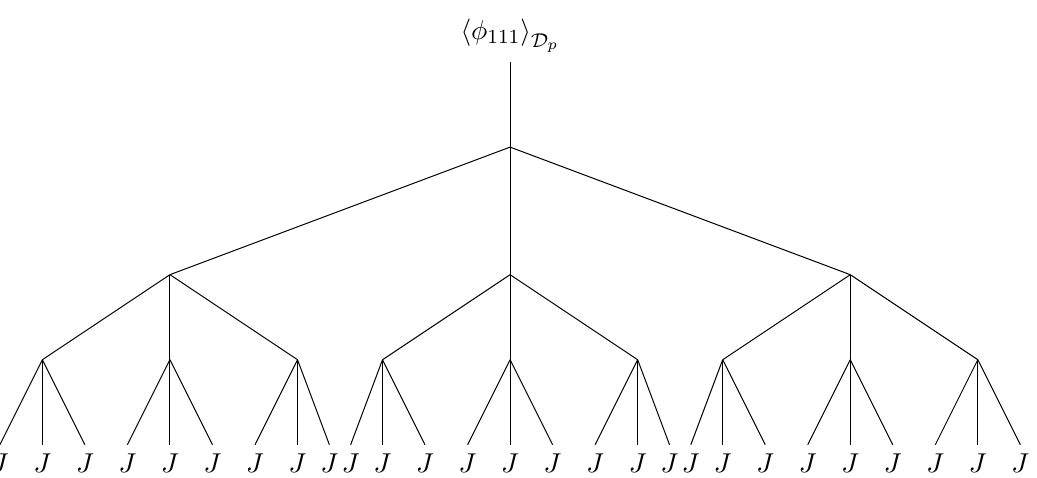
Figure 1 . The contribution to the one-point function h φ 111 ( x ) i grams, where each edge is the exact propagator (containing nested melons) of the tensor model in the large N limit